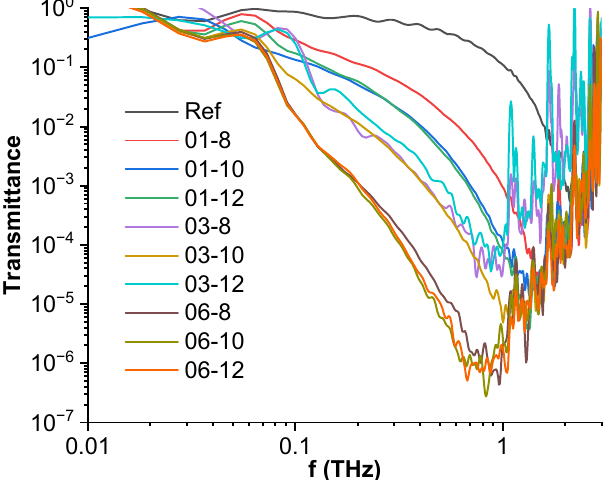
Figure 8. Time domain spectroscopy transmittance spectra for PBS hybrid nanocomposites.